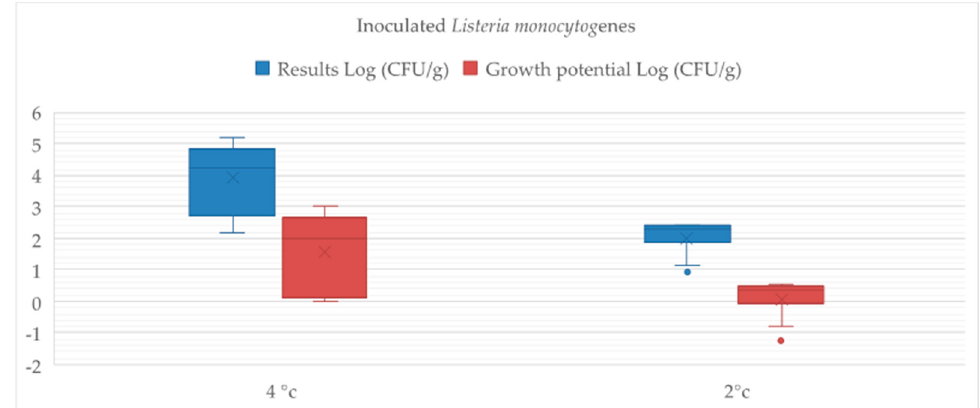
Figure 1. Effect of post dry aging on Listeria growth in inoculated samples of buffalo S+/F meat stored at 2° and 4 °C. Listeria concentration (Log (CFU/g)) and growth potential (Log (CFU/g)) are expressed as means ± SEM for each inoculated group.